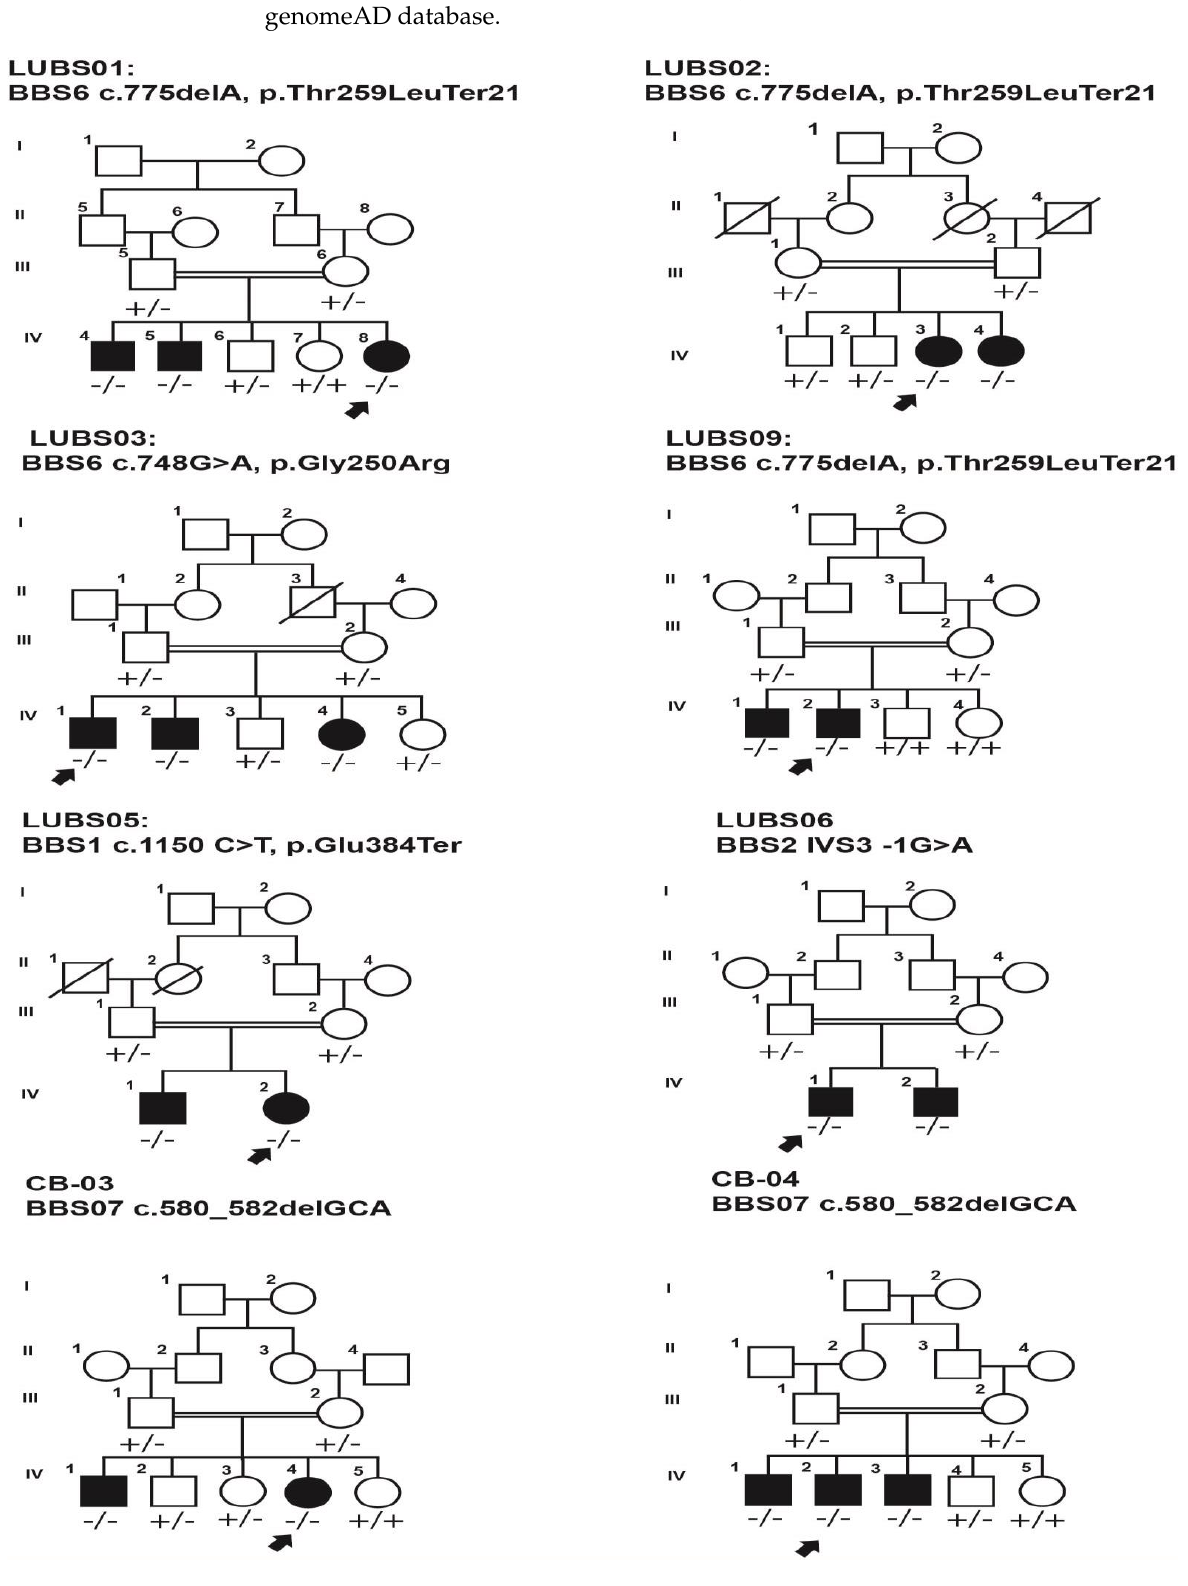
Figure 1. Pedigrees affected with Bardet-Biedl Syndrome carrying known variations in BBS genes. The Ramachandran plot was used to predict the effect of amino acid substitution on protein structure. It compares the stereo-chemistry and geometry of wild and mutant types of protein structure by analyzing the angles of amino acids. The wild type and mu- tant proteins revealed a non-comparable range. The wild-type protein carried 82% and